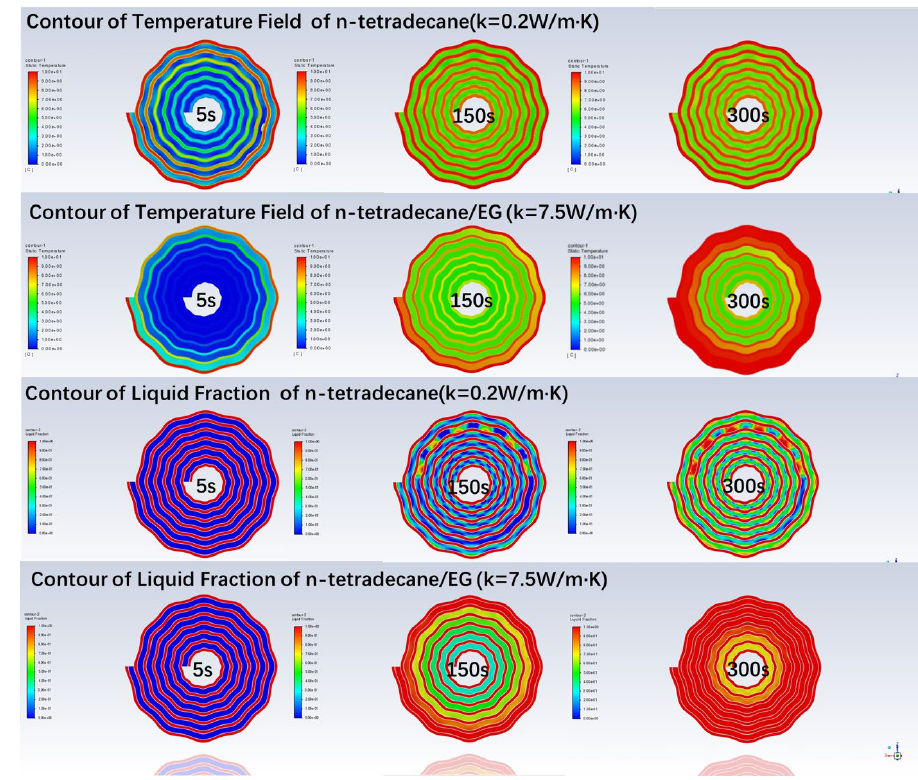
Figure 13. Contours of temperature and liquid fraction at different time.